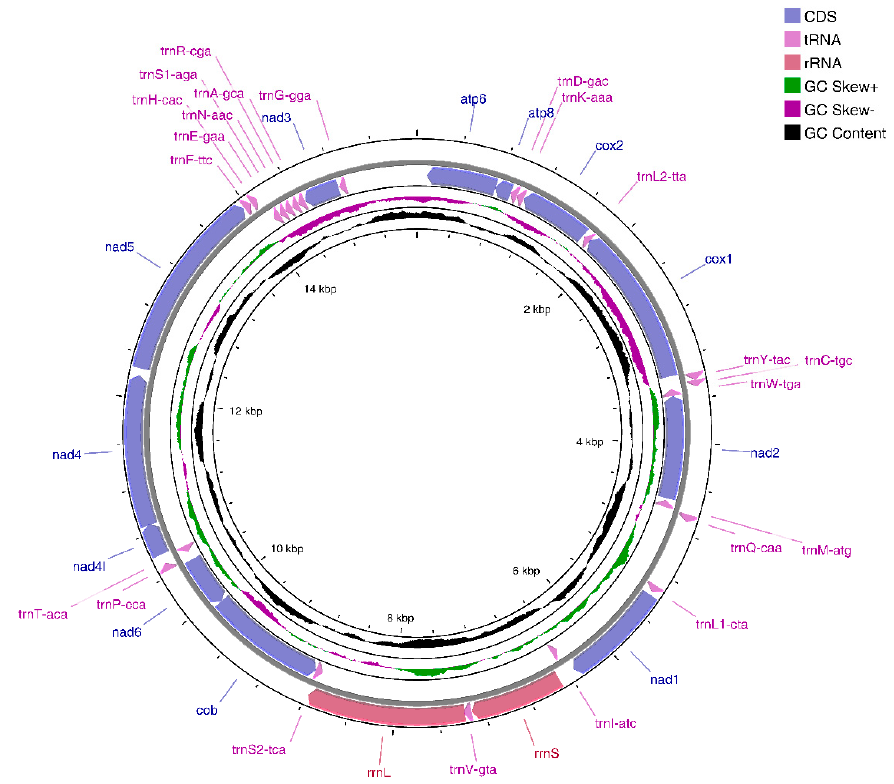
Figure 1. Complete mitogenome map of E. crenata . 14 genes are encoded on the heavy (H) strand and 23 genes are encoded on the light (L) strand. Genes for proteins and rRNAs are represented with standard abbreviations. Genes for tRNAs are shown in a single letter for the corresponding amino acid, with two leucine tRNAs and two serine tRNAs distinguished by numerals. Table 2. Mitogenome organization of E. crenata .